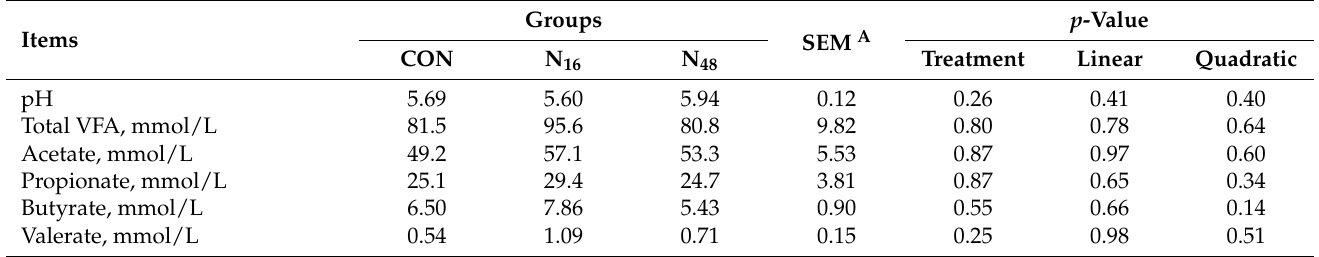
Table 6. Effects of the fruit of Nitraria tangutorum (FNT) supplement on ruminal pH and fermentation variables in Hu